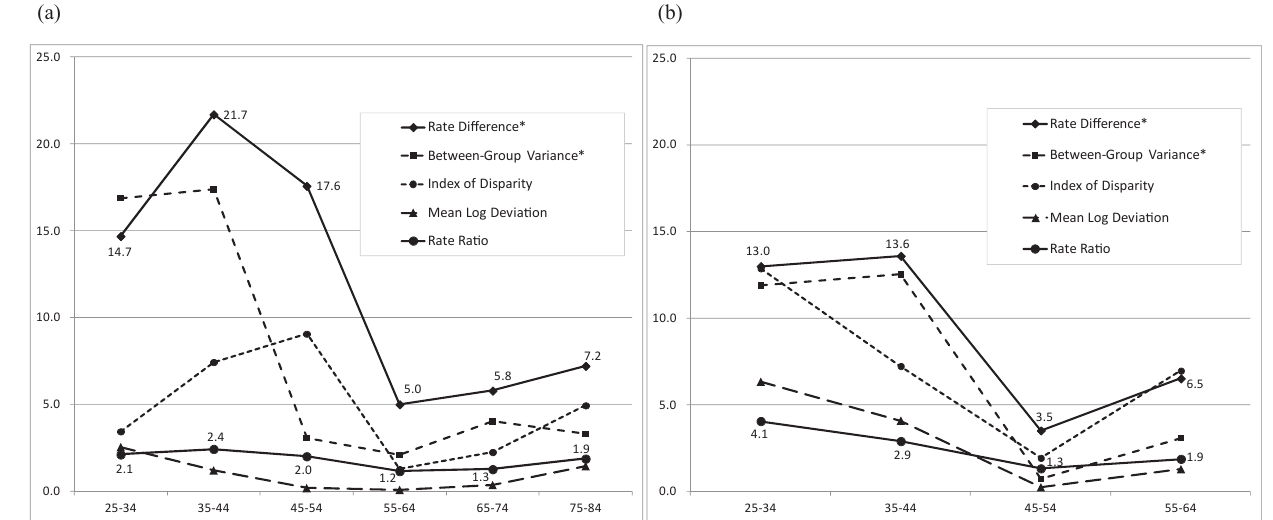
Fig. 2. Sex- and age-speci fi c estimates of inequality indicators for educational inequality in heavy smoking among daily smokers: (a) men and (b)